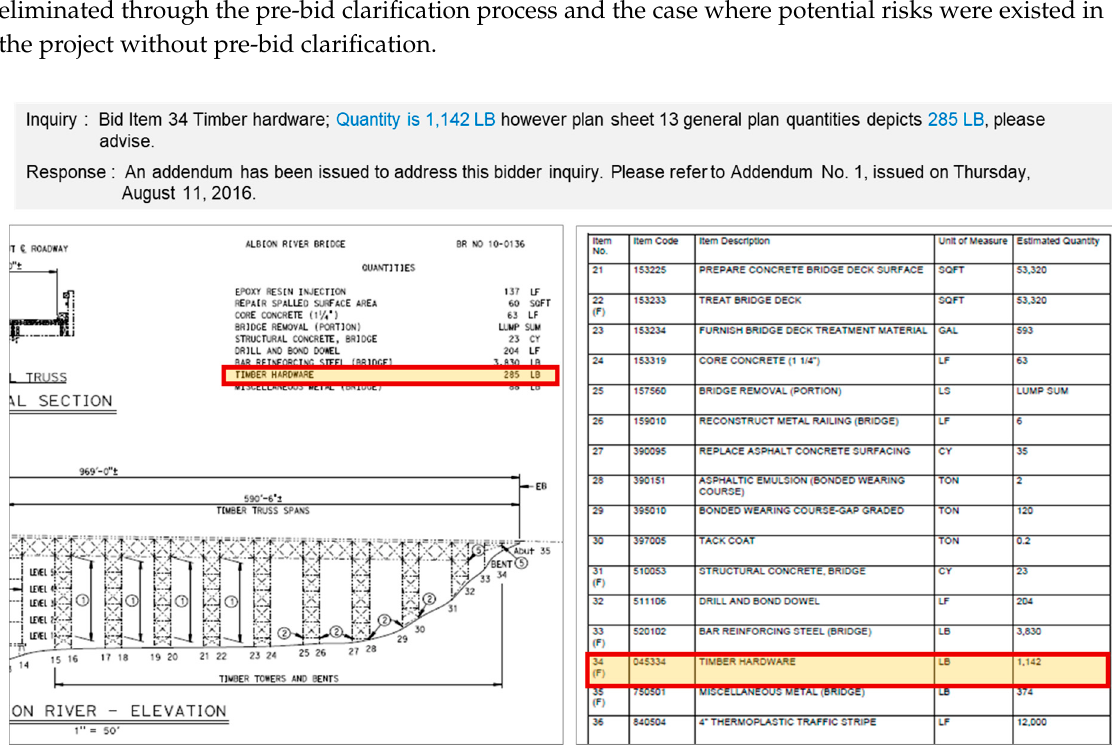
Figure 1. Example of pre-bid clarification.